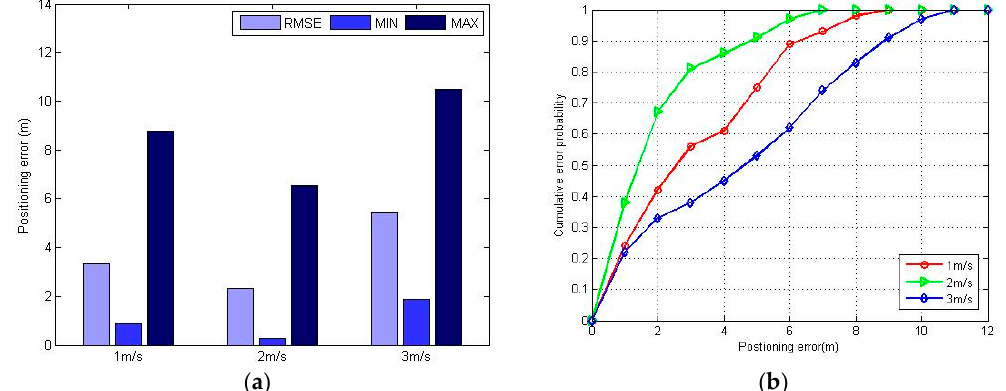
Figure 11. The positioning error at different walking speeds using FPR algorithm: ( a ) maximum positioning error, minimum positioning error and RMSE at different speed; ( b ) CDF at different speed.